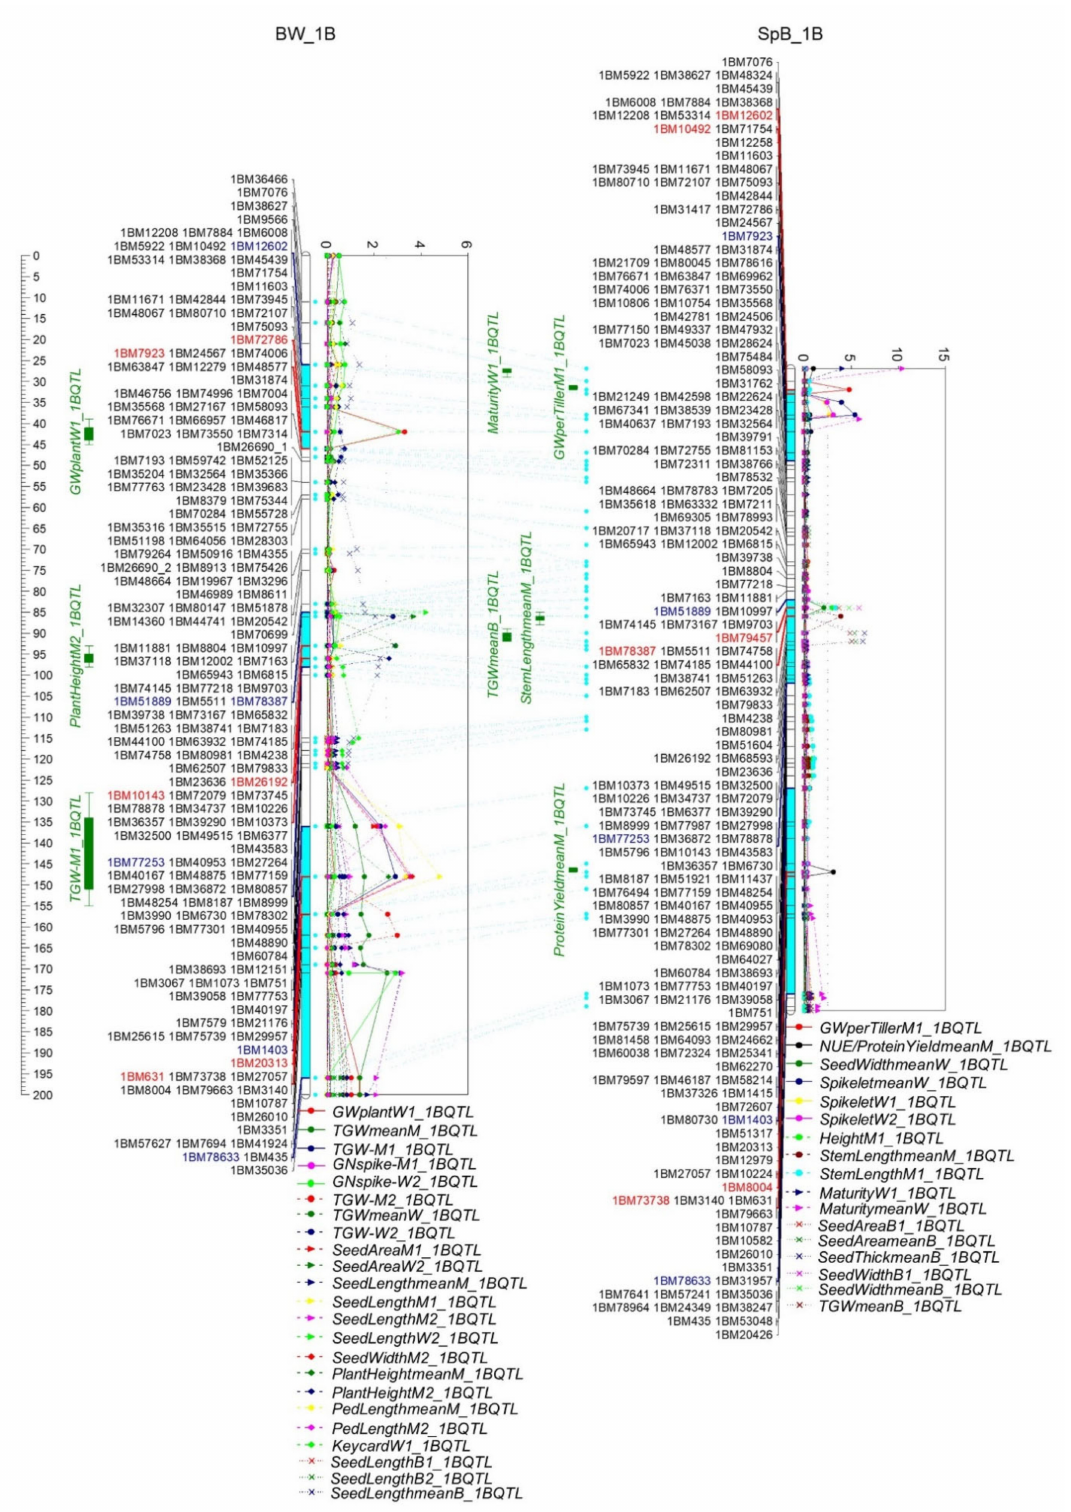
Figure 6. Significant QTL formed three QTL clusters on the homologous region on 1B in both populations, BW and SpB. Homologous regions in both populations are highlighted in light blue; markers for QTL highlighted in red; homologous markers highlighted in